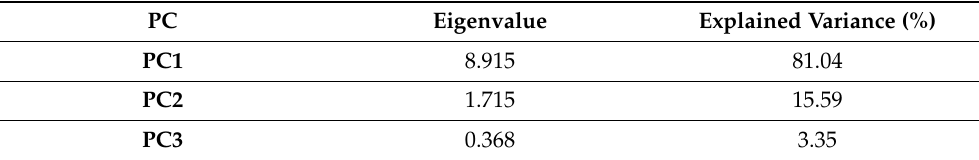
Table 8. Summary of the PCA analysis of selected